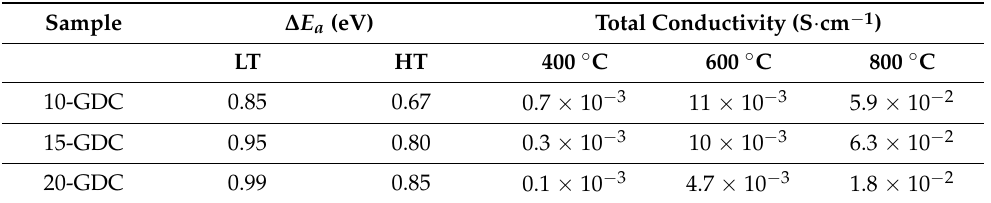
Table 2. Values of the bulk ( ∆ E b ), grain boundary ( ∆ E gb ), and total ( ∆ E total ) conductivity and